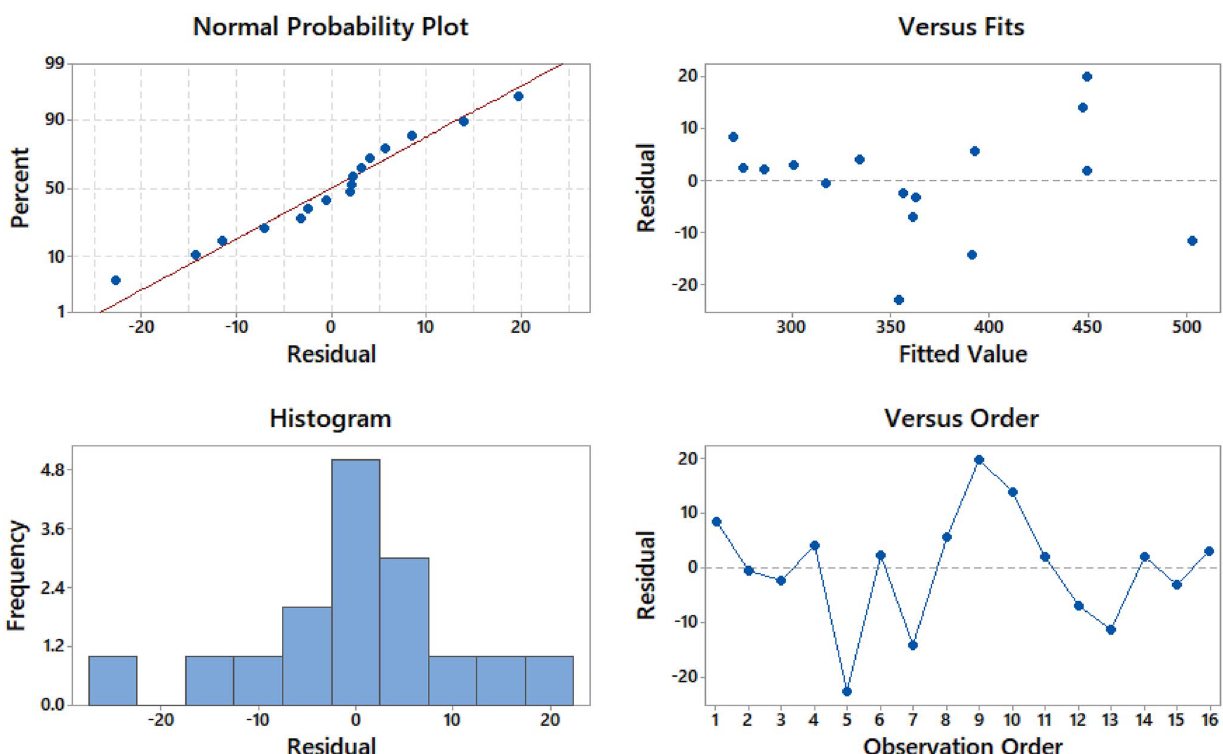
Fig. 23 Residual plot of the cutting force F z for SiCp/Al